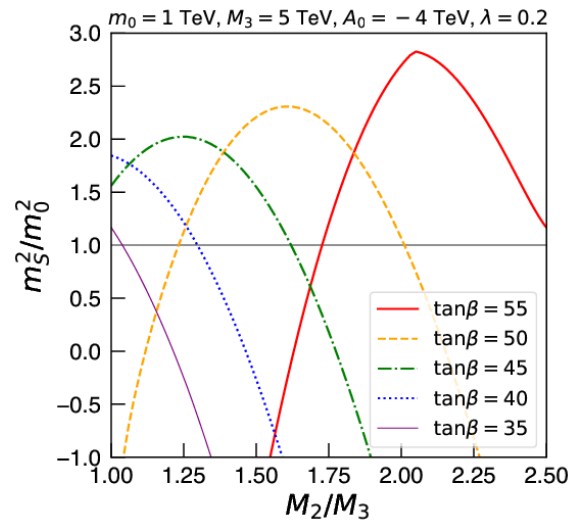
Figure 1. m 2 =m 2 at the GUT scale as a function of the gaugino mass ratio M 2 =M 3 for di(cid:11)erent 0 S values of tan (cid:12) . Here, we take m 0 = 1 TeV, M 3 = 5 TeV, A 0 = (cid:0) 4 TeV, and (cid:21) = 0 :